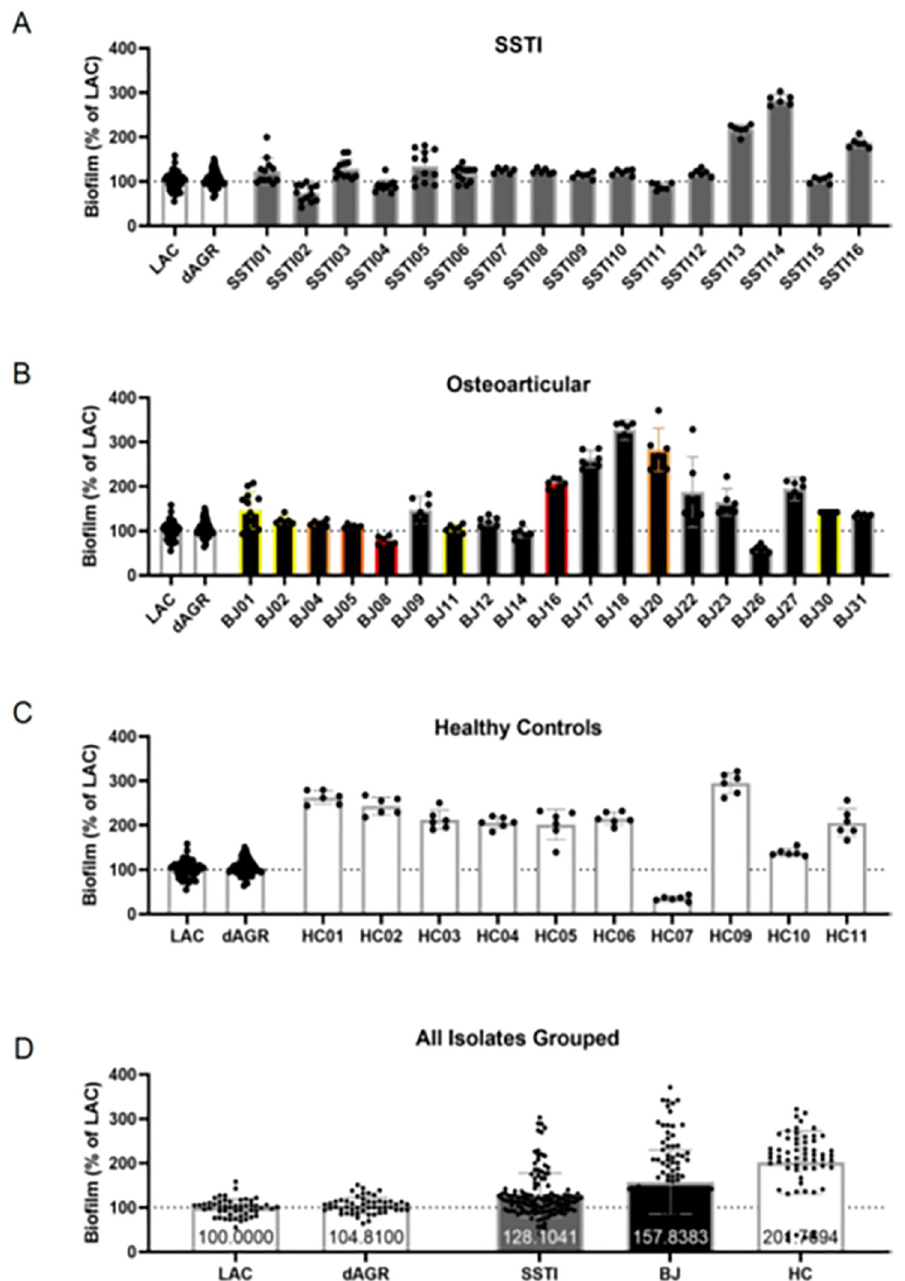
Fig 4. Biofilm formation capacity of Staphylococcus aureus isolates. The capacity for each isolate to form biofilm was assessed using a 24-hour static biofilm assay. Results are grouped by infection type with A) skin and soft tissue abscess isolates B) osteoarticular isolates and C) healthy control isolates. D) All data for each infection type were combined to generate grouped pools. Data represent the mean ± SD and are the result of at least two biological replicates with at least seven technical replicates. The USA300 LAC (AH1263) and the isogenic agr -deletion mutant (AH1292) were included for internal control and comparison. For grouped isolates (D), only the healthy control group demonstrated significantly more robust biofilm formation than any other group (in comparison with skin and soft tissue isolates, p = .02). SSTI = skin and soft tissue infection; BJ = bone and joint infection; HC = healthy controls.